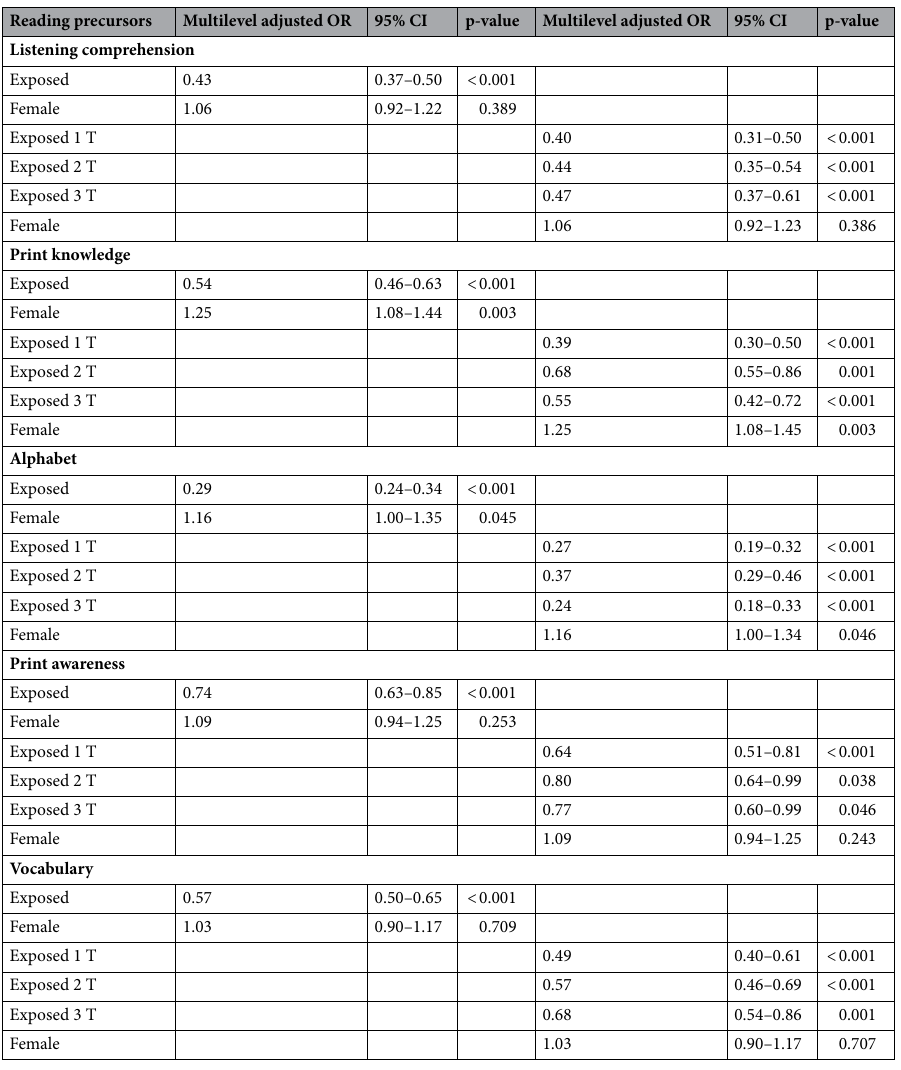
Table 4. Multilevel analysis of achievement the highest category in exposed and unexposed children. T1: exposure in the first trimester of gestation; T2: exposure in the second trimester of gestation; T3: exposure in the third trimester of